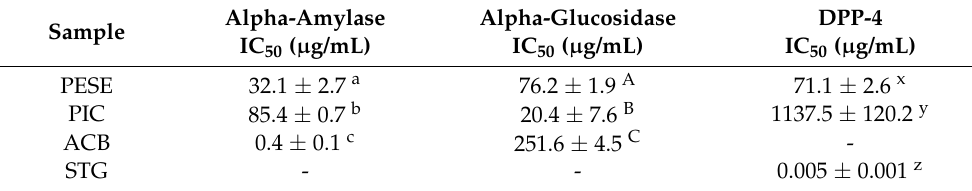
Table 1. Antidiabeticactivityin vitroofethanolicextractof P.edulis